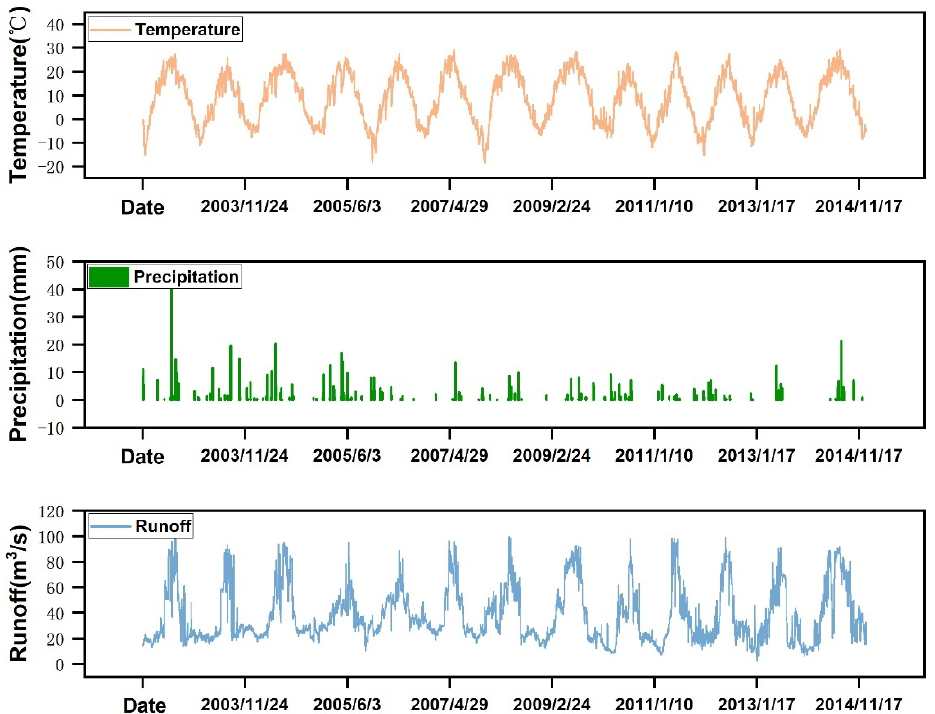
Figure 2. Meteorological data and runoff distributions in the Yarkant River Basin from 2002 to 2014.